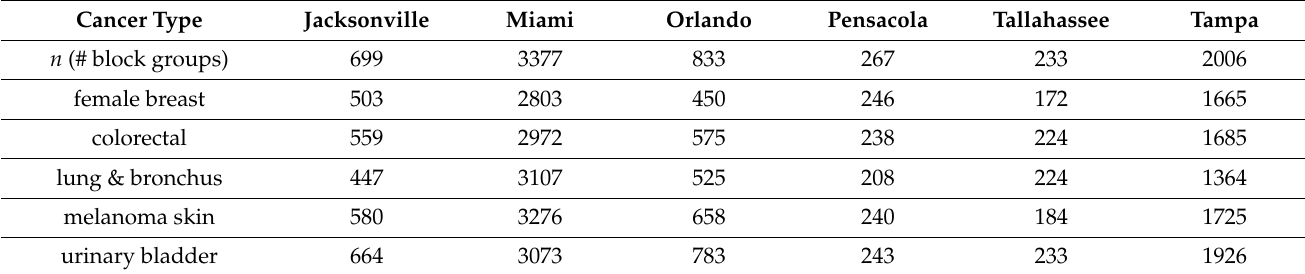
Table 7. Approximate effective geographic sample size, n